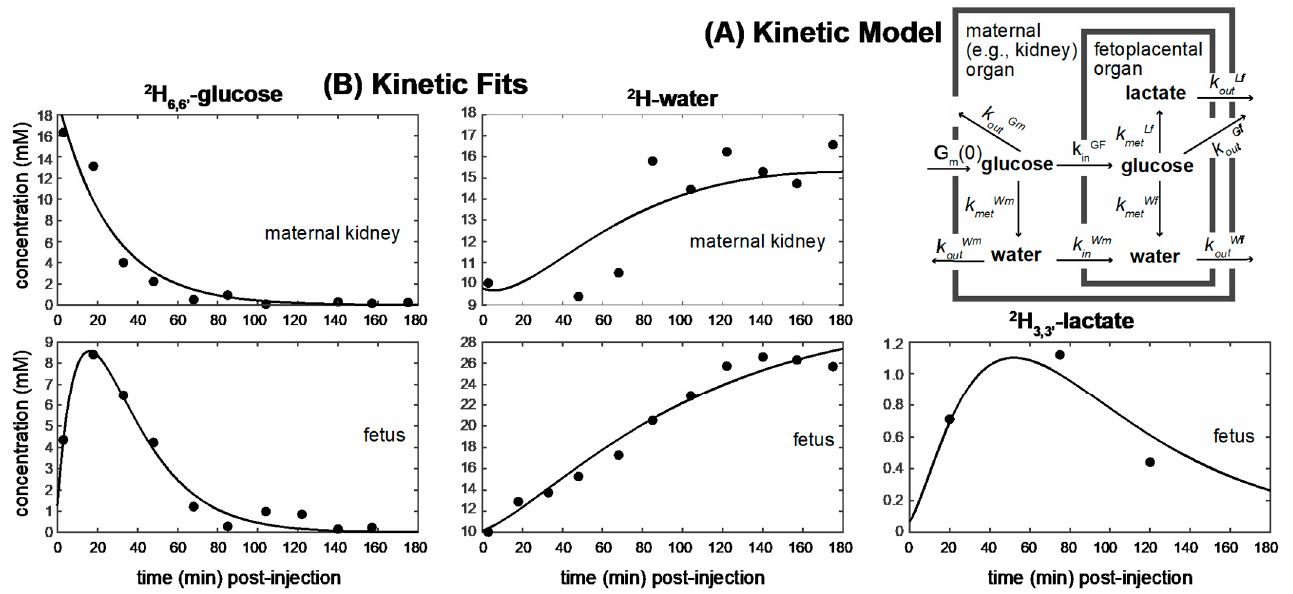
Figure 5. ( A ) Model assumed in this study to describe the exchanges between fetoplacental and maternal glucose, water and lactate, and fit the time evolutions observed for these metabolites by DMI. Indicated are the kinetic constants introduced in the fits (Equations (1)–(5)); missing arrows represent slower or ill-defined processes whose effects were not accounted for in this model; k out s include kinetic process as well as other generic sources of MR signal loss. Notice that the fitting process also requires an initial 2 H 6,6 ′ -glucose concentration G m (0). ( B ) Example of fits arising from this model for maternal kidney and fetal voxels, observed following an injection of 2 H 6,6 ′ -glucose to a pregnant mouse that has been administered l-NAME. Supplementary Figure S25 shows similar quality fits arising for all the data sets analyzed in this study. Average results of these fits are presented in Table S1 for the control and preeclamptic cohorts.